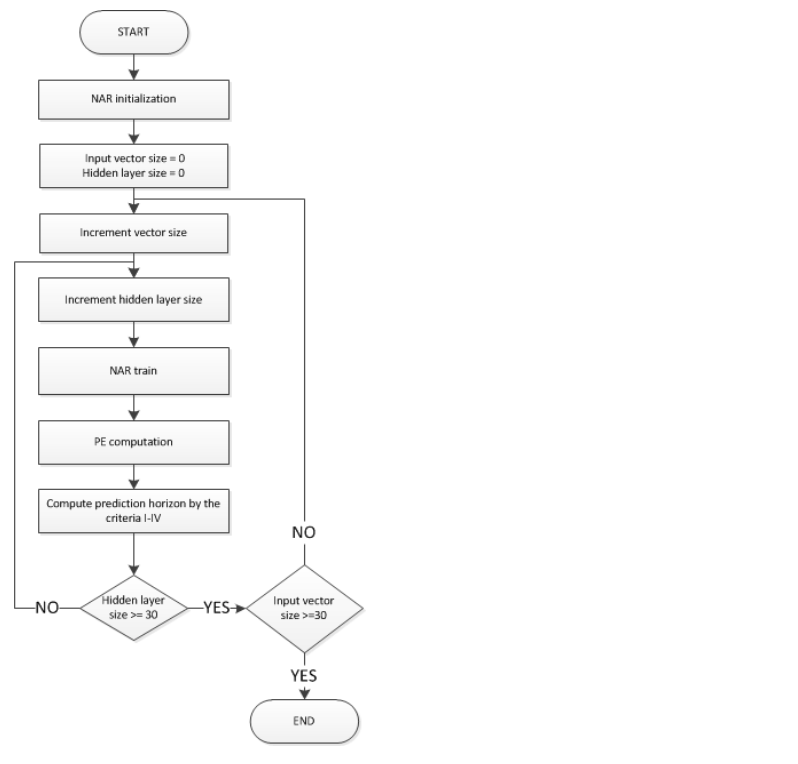
Figure 7. The simulation algorithm implemented in the MATLAB program.